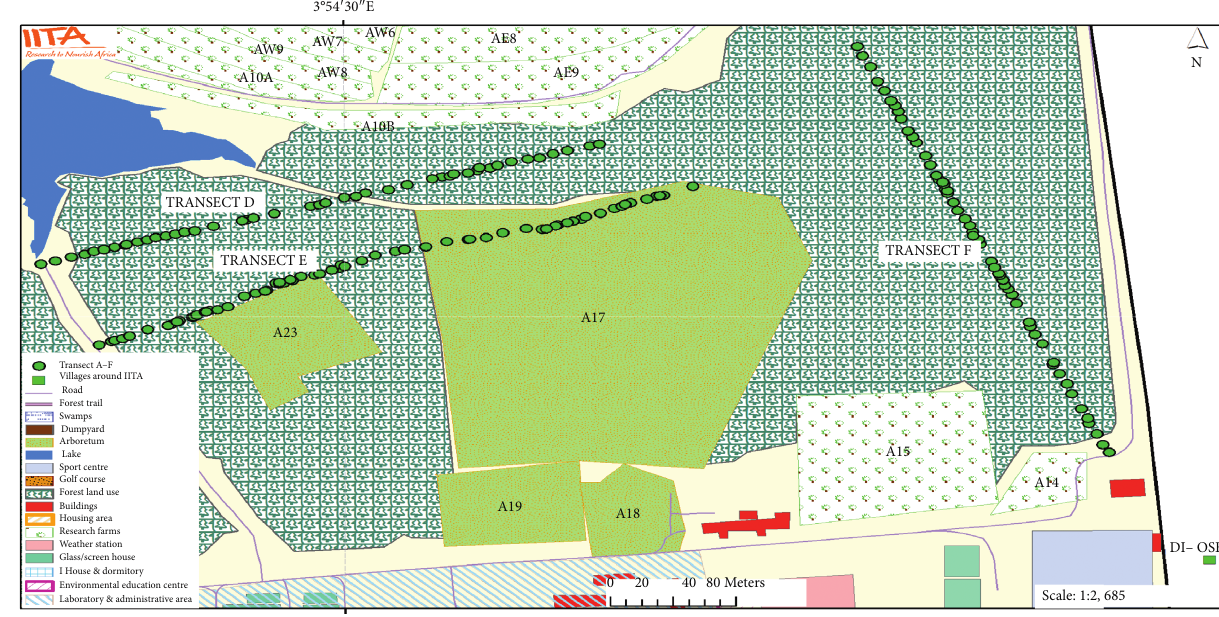
Figure 3: Map of block A forest showing the location of transects D , E , and F